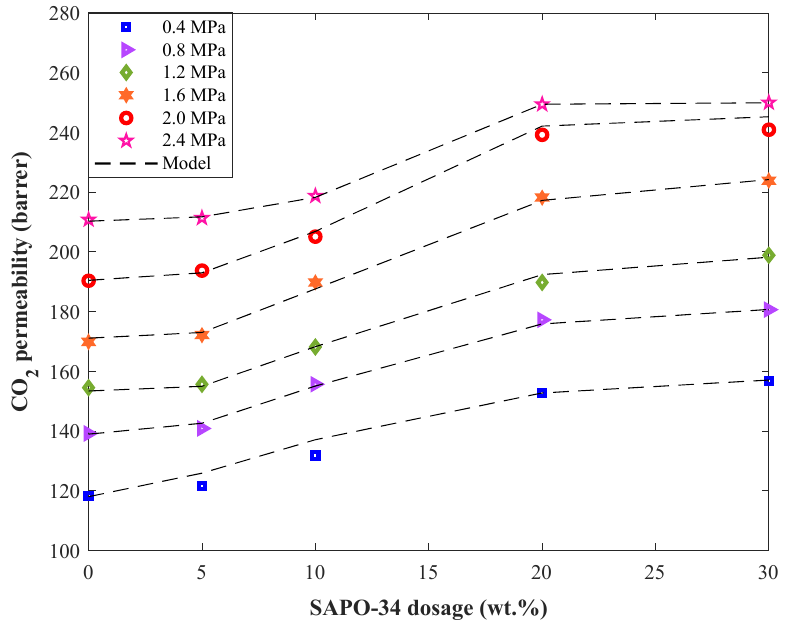
Figure 6. Monitoring the effect of SAPO-34 dosage and pressure on the CO 2 permeability in Pebax- 1074-based MMM (298 K).